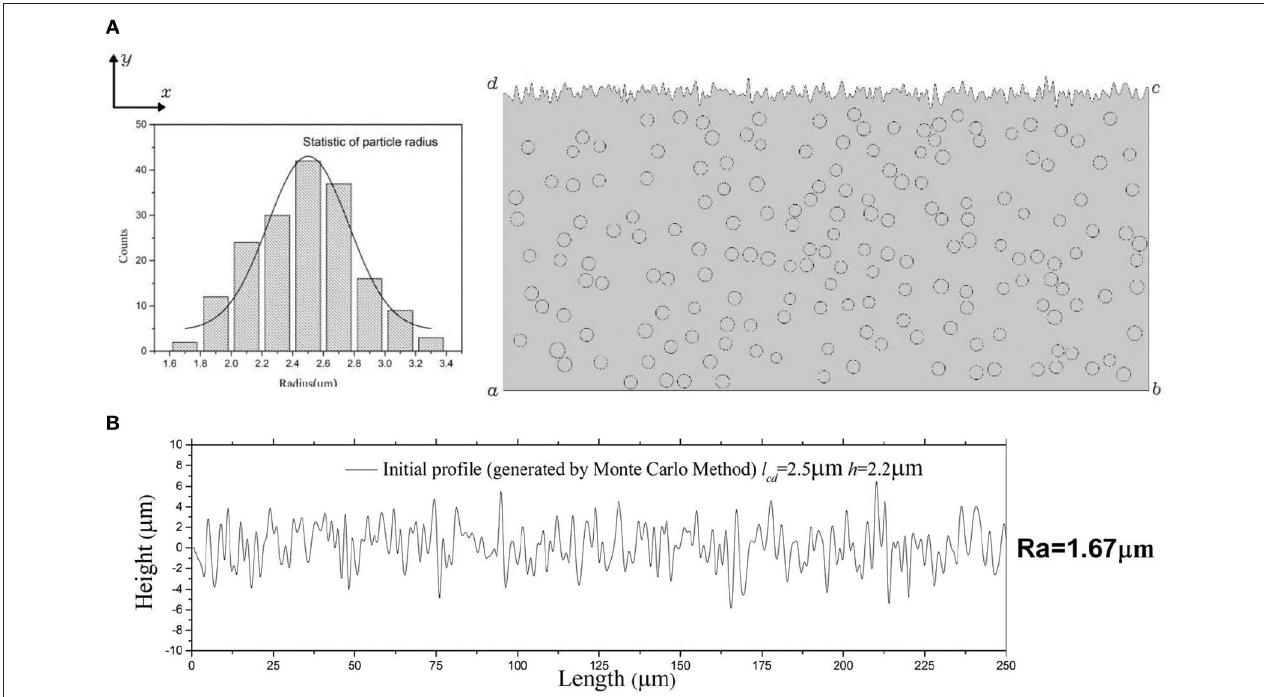
FIGURE 1 | The two dimension mesoscopic model of MRE. (A) Left: statistic distribution of particle sizes, the total number of particles N the particle radius is 2.5 µ m. Right: the particles are uniform distributed in a (250 generated initial surface micro profile of the MRE model. The surface roughness of the MRE ( Ra ) is 1.67 µ